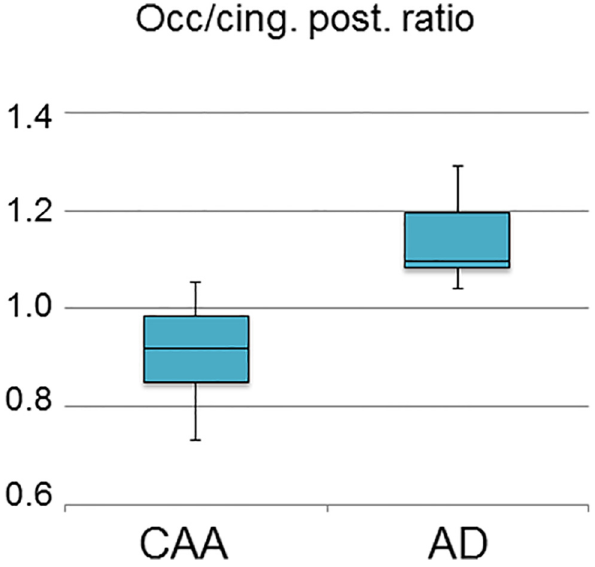
Fig 1. Box plot showing the highly significantly lower early-phase 11 C-PiB occipital/posterior cingulate SUVR ratio in CAA patients (n = 11) as compared to Alzheimer ’ s disease (AD; n = 7) (p = 0.002, Mann-Whitney non-parametric